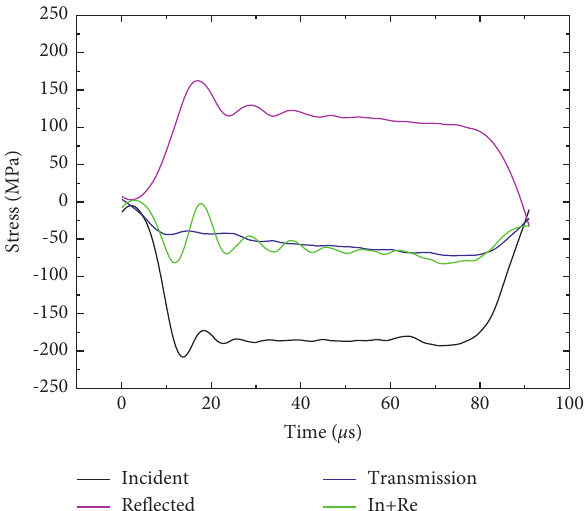
Figure 8: Diagram of the stress-time curve.